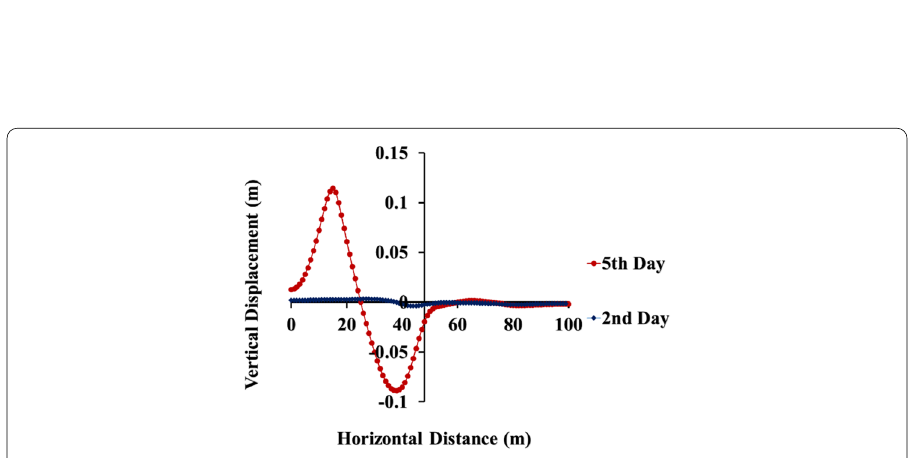
Fig. 23 Vertical displacement profile along the base of the dam during reservoir drawdown after the steady-state phreatic surface is achieived with the earthen